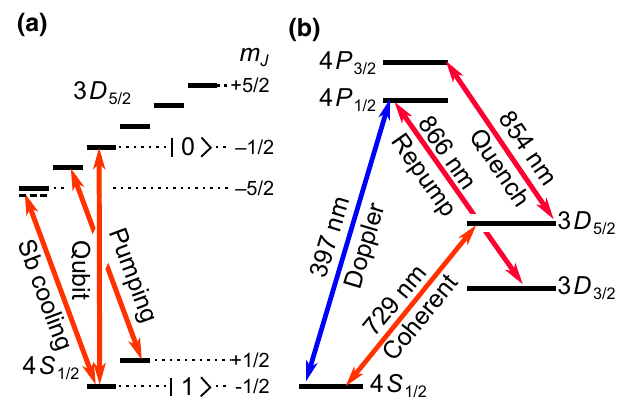
FIG. 1. Energy levels and relevant transitions in 40 Ca + for the quantum computing demonstrator. (a) Ground and excited state fine structure manifold with electric quadrupole transitions for sideband (sb) cooling on the first red sideband, optical pumping, and the (cid:3) m J = 0 qubit transition. (b) Ground, excited and aux- iliary levels in 40 Ca + with transitions for Doppler cooling and detection, repumping, and quenching of the excited state lifetime during sideband